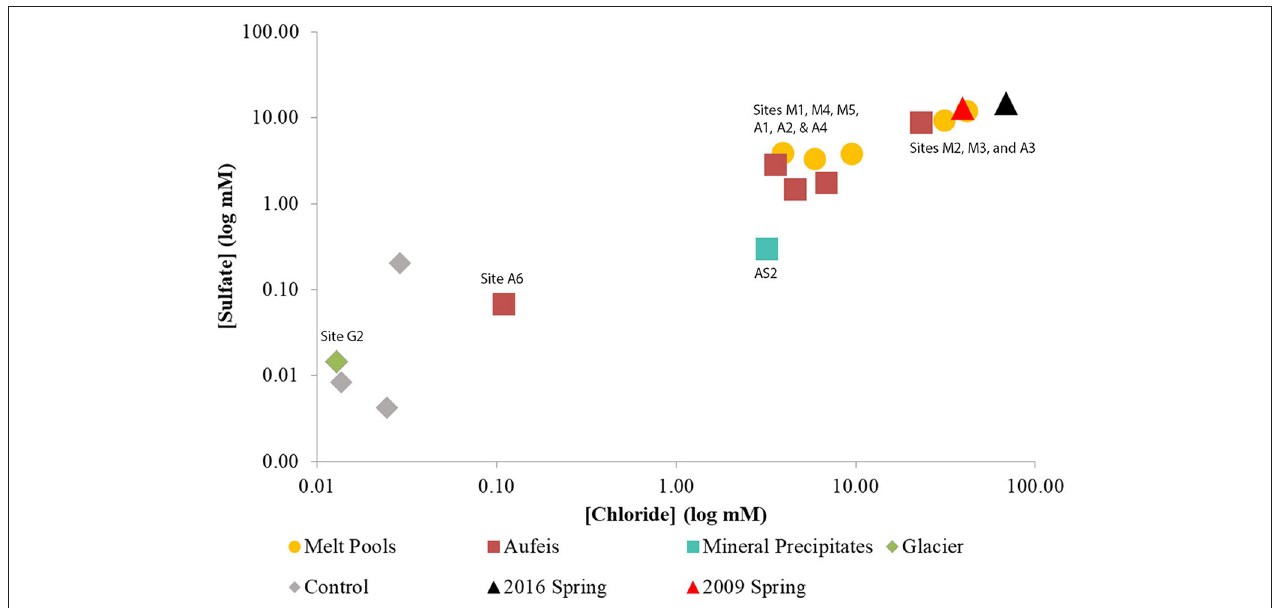
FIGURE 2 | Log-log plot of sulfate vs. chloride aqueous geochemistry data. Sulfate and chloride aqueous geochemistry data appear to trend together. Note the “Control” samples which have been added for geochemical comparison, however, there is no 16S rRNA gene sequencing data associated with these samples. Both sites (M4 and M5) which were located on top of the Ice Blister are lower in sulfate and chloride concentrations than those located just to the west (Sites M2 & M3) and south (G2). These also match closely with aqueous geochemistry data taken from spring fluids from 2009 to 2016.